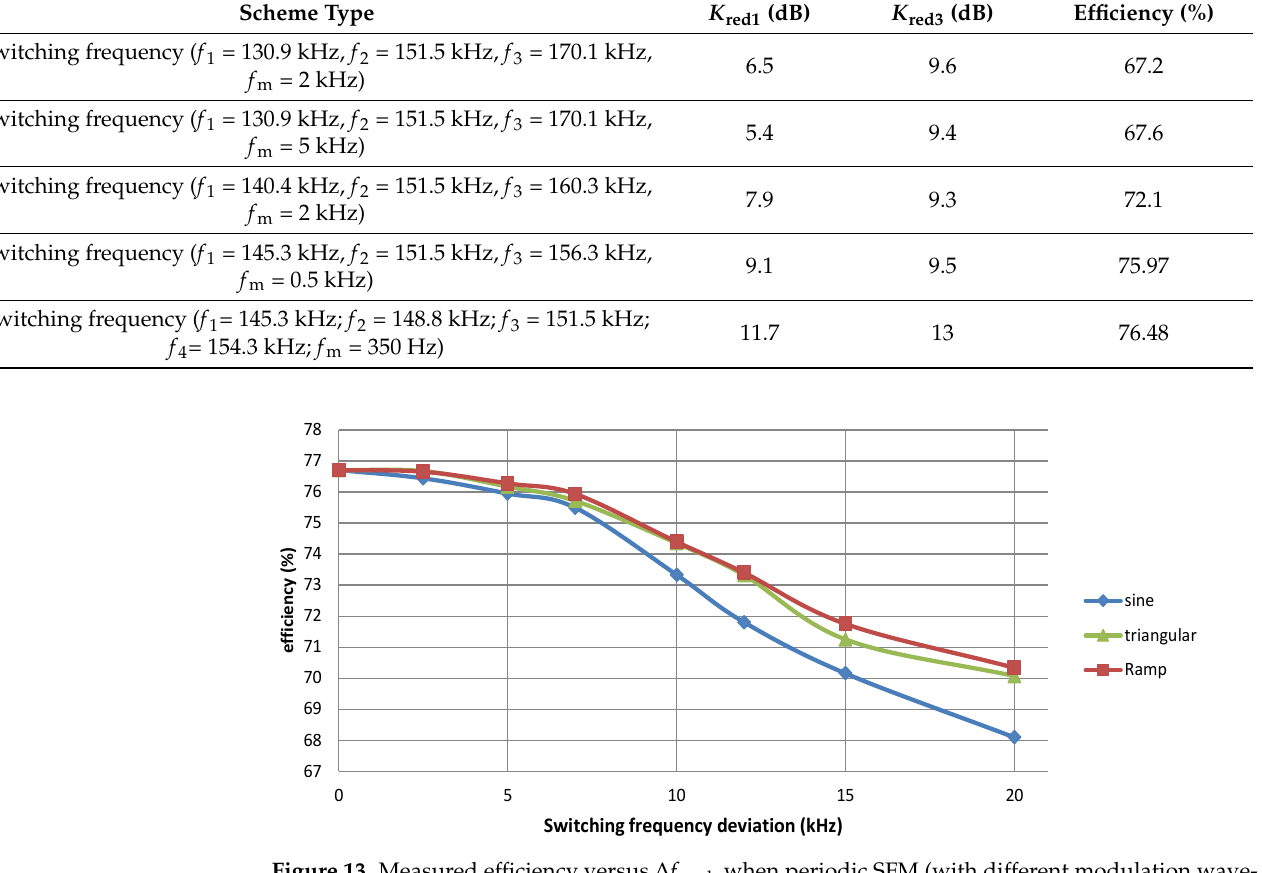
Figure 15. Measured efficiency versus f m when periodic SFM (with different modulation waveforms and Δ f peak = 5 kHz) is used.